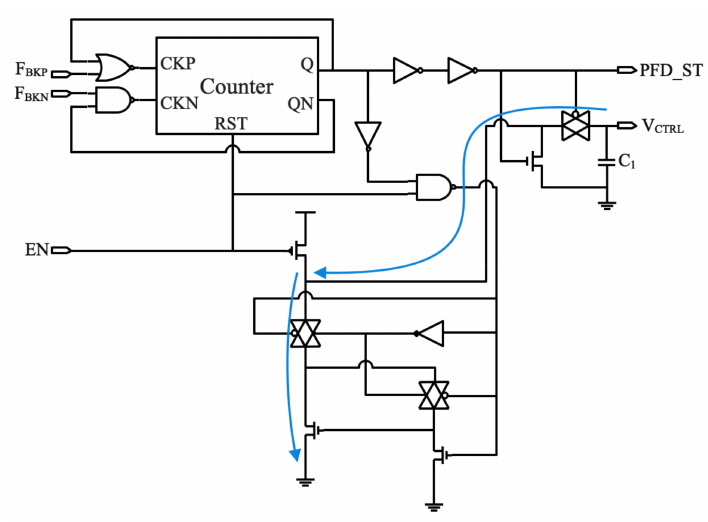
Figure 4. The diagram of the start-up